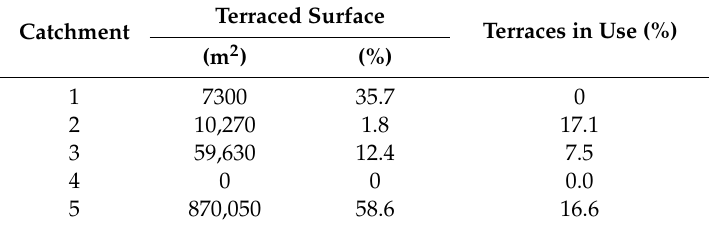
Table 4. Terraced surface and the in use / maintained percentage for the studied